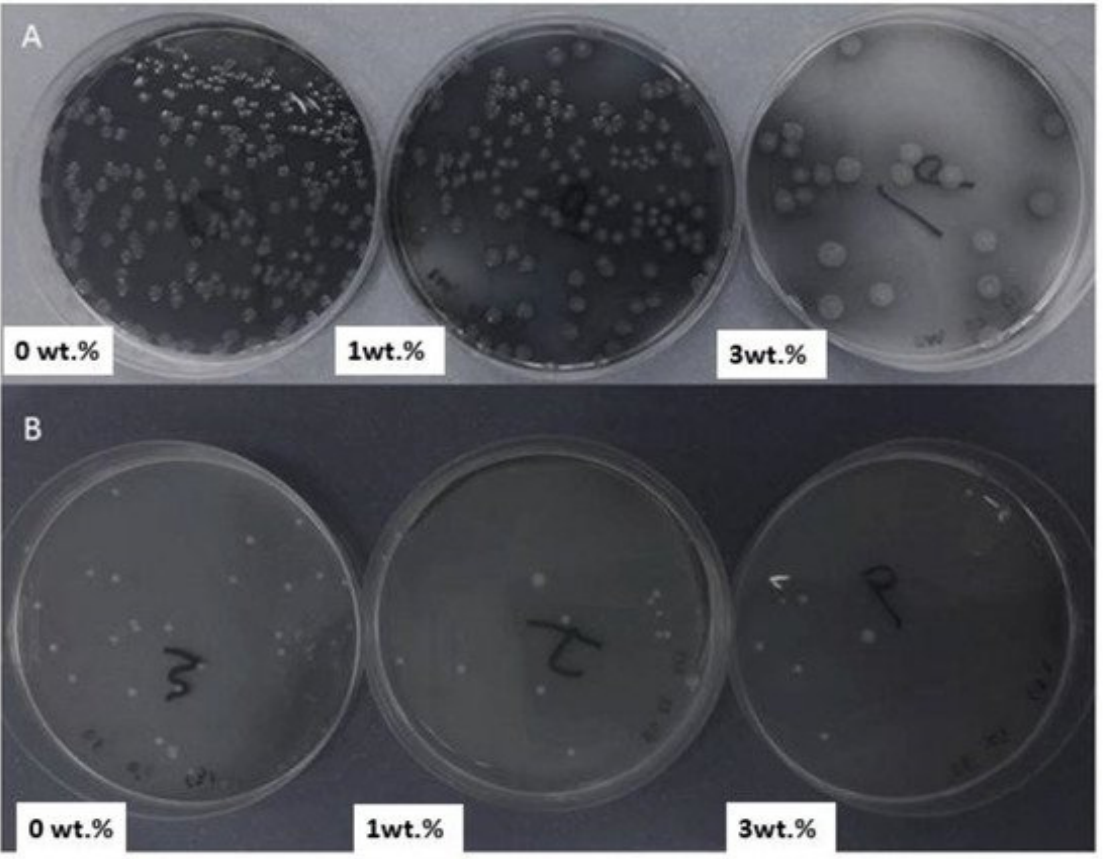
Figure 5. C.F.U. of P. aeruginosa ( A ) and E. faecalis ( B ) on nutrient agar after growing it for 48 h on PMMA composites containing 0, 1, and 3 wt% TiO 2 . Reprinted from ref. [100], copyright 2018, MDPI.